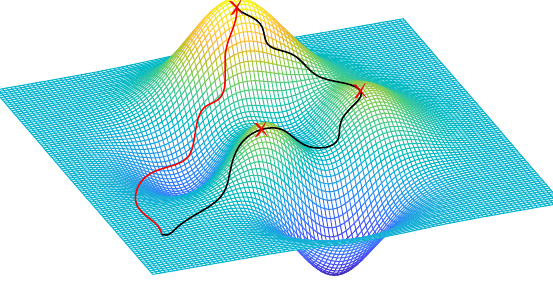
Figure 4. Two paths to explore the optimal strategy.